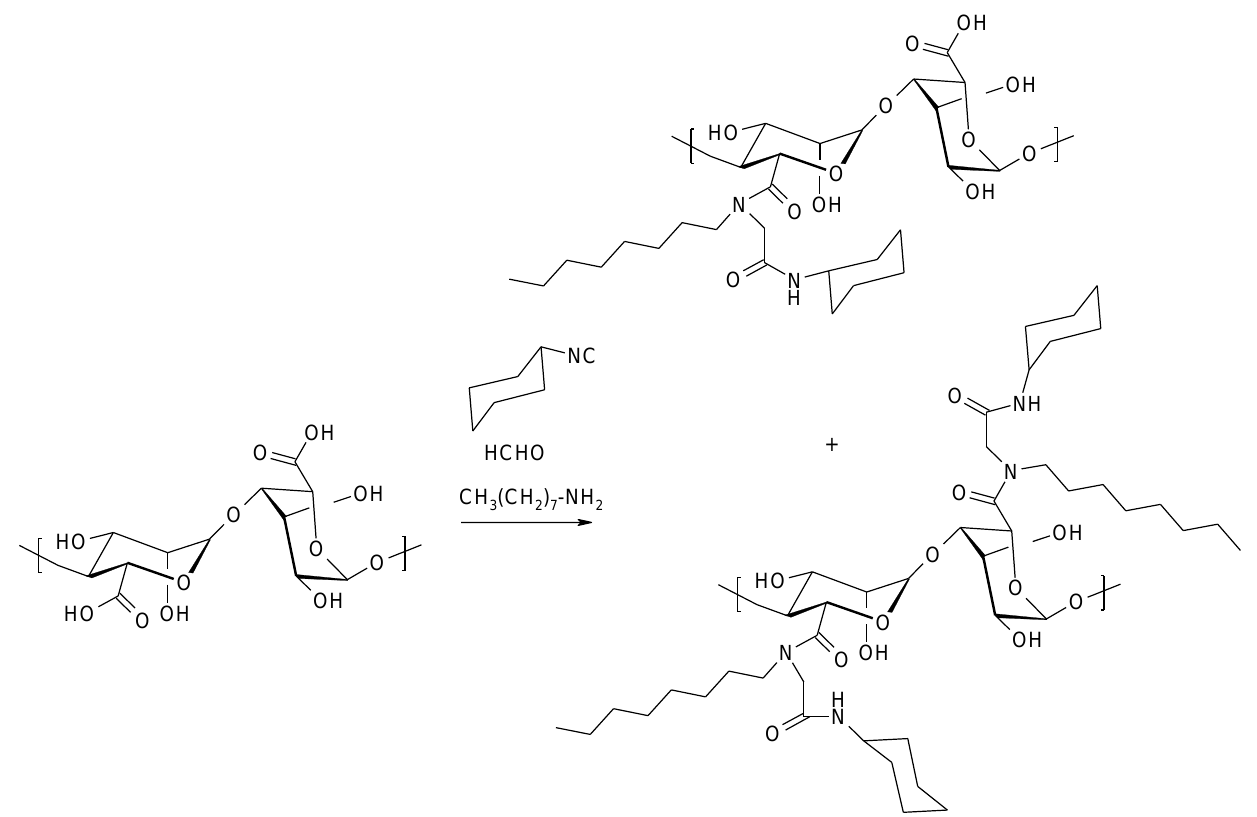
Figure 19. Ugi multi-component reaction for the preparation of amide alginate derivatives.